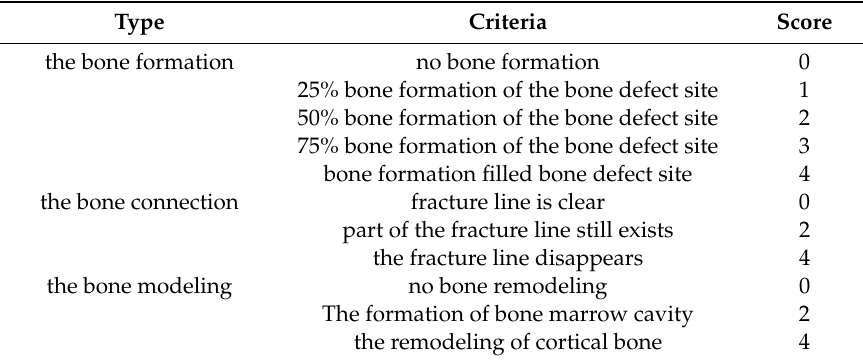
Figure 9. ( A ) The X-ray images of radius defect site after 4, 8 and 12 weeks of nHD-2 scaffolds’ and hydroxyapatite/collagen composite (HC) scaffolds’ repairs in New Zealand rabbits, respectively. Blank groups represent radius defect sites where no scaffolds were implanted into, which were used for comparison with test groups nHD-2 and positive control HC (commercially available bone scaffolds). ( B ) The overall Lane–Sandhu X-ray scores were elevated on the blank group, nHD-2 and HC scaffolds, respectively. * p < 0.05. Table 1. The International Lane–Sandhu X-ray score